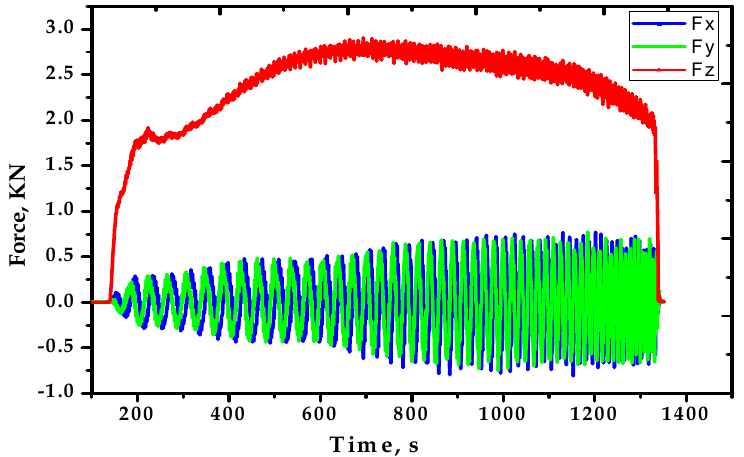
Figure 14. Forming forces in the three directions for the cone produced with run 5.